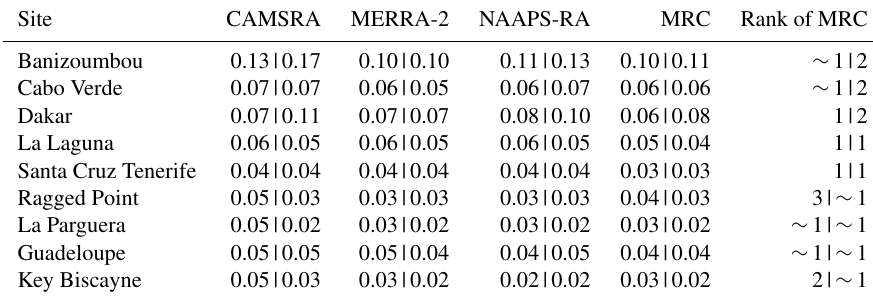
Table 1. Root mean square error of total AOD (left number in each cell) and coarse-mode AOD (right number in each cell) at 550nm from individual aerosol reanalyses, including CAMSRA, MERRA-2, NAAPS-RA, and the multi-reanalysis consensus (MRC) verified with AERONET V3L2 monthly data for the 2003–2018 time period. The rank of MRC among all reanalyses in terms of root mean square error (RMSE) is also shown. “ ∼ ” means there are ties in the ranking. The first five sites are located in North Africa or off of the northwestern coast of Africa. The last four sites are located in or near the Caribbean Sea. AOD time series of MRC and AERONET at Dakar, Cabo Verde, Ragged Point, and La Parguera sites are presented in Fig.